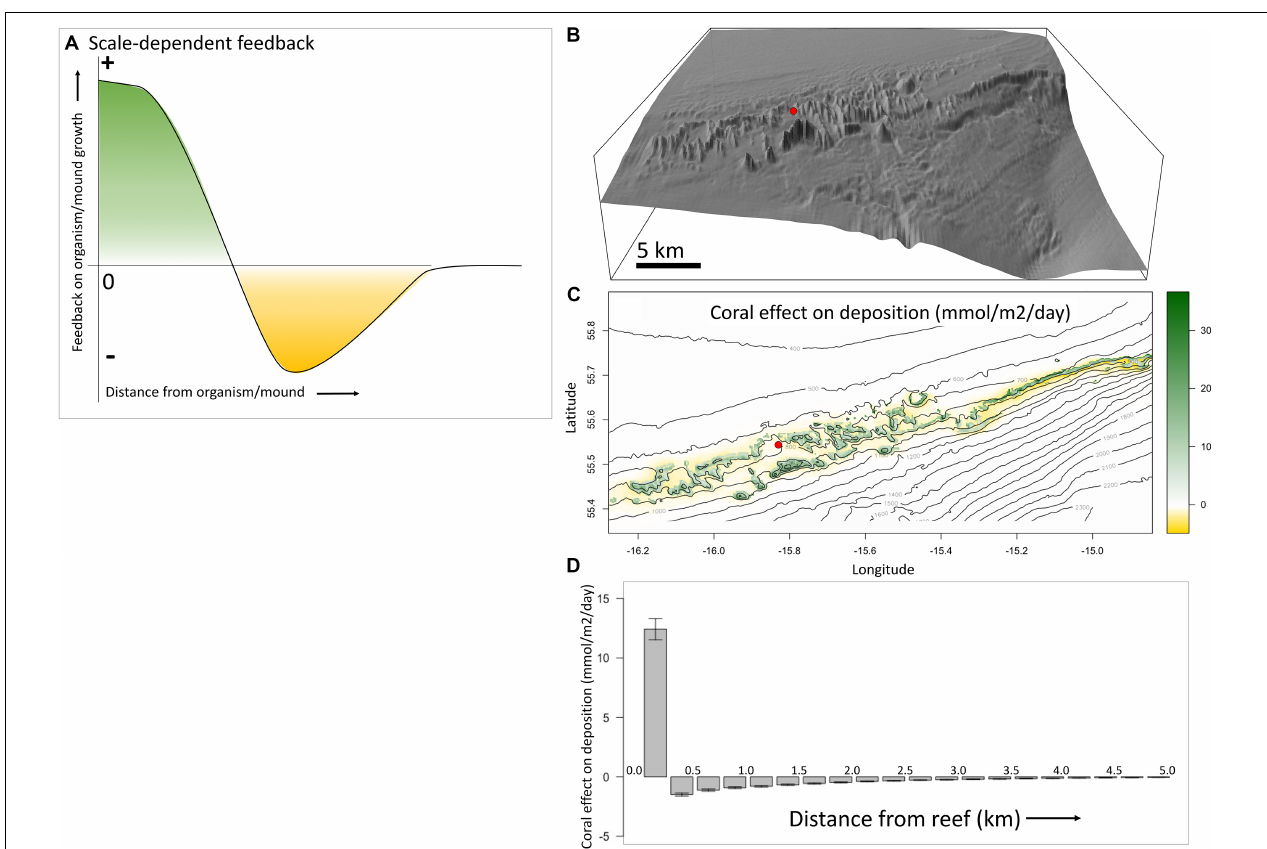
FIGURE 2 | Scale-dependent feedbacks visualized. (A) Depicted are the proposed scale-dependent feedbacks as caused by the presence of coral mounds, in a classic scale-dependent feedback figure (e.g., Figure 1B in Rietkerk and van de Koppel, 2008). Near the mound there is a positive feedback (green) on reef-, and therefore mound-, growth, whereas there is a negative feedback (yellow) at a larger distance from the mound. (B) The study area of the Southwest Rockall Trough (Logachev) area. The red circle serves as a reference to the map in panel (C) . (C) The effect of coral presence on organic carbon deposition (mmol m - 2 day - 1 ) is mapped, with positive effects in green and negative effects in yellow. It shows a positive effect of reefs on their food supply on the mounds, and a negative effect around the mounds. (D) This classic scale-dependent feedback plot shows the average effect of coral reefs on their food supply, with error bars showing the 95% confidence level. Locally (distance = 0) there is a mean positive effect on deposition and until about 3 km from the reefs there is a mean negative effect. These feedbacks are illustrated using model output from Soetaert et al. (2016), for the SW Rockall Trough